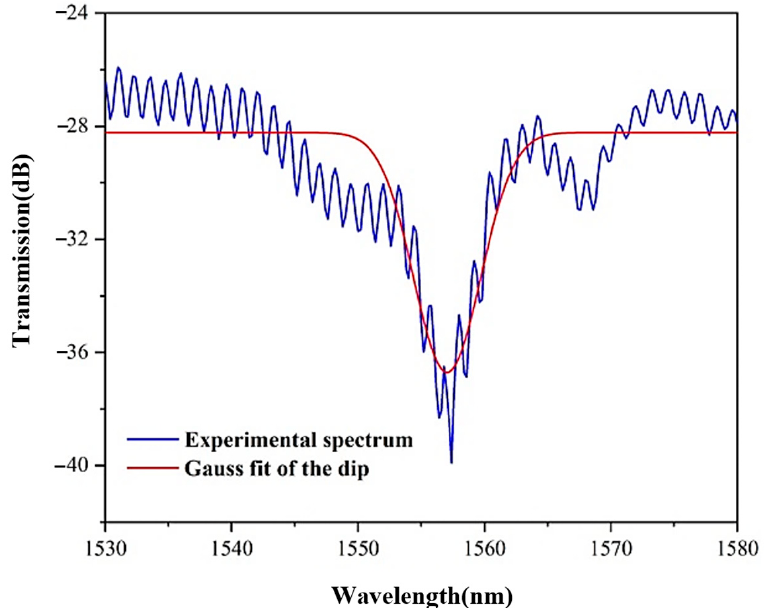
Figure 8. The Gaussian fitting of the dip